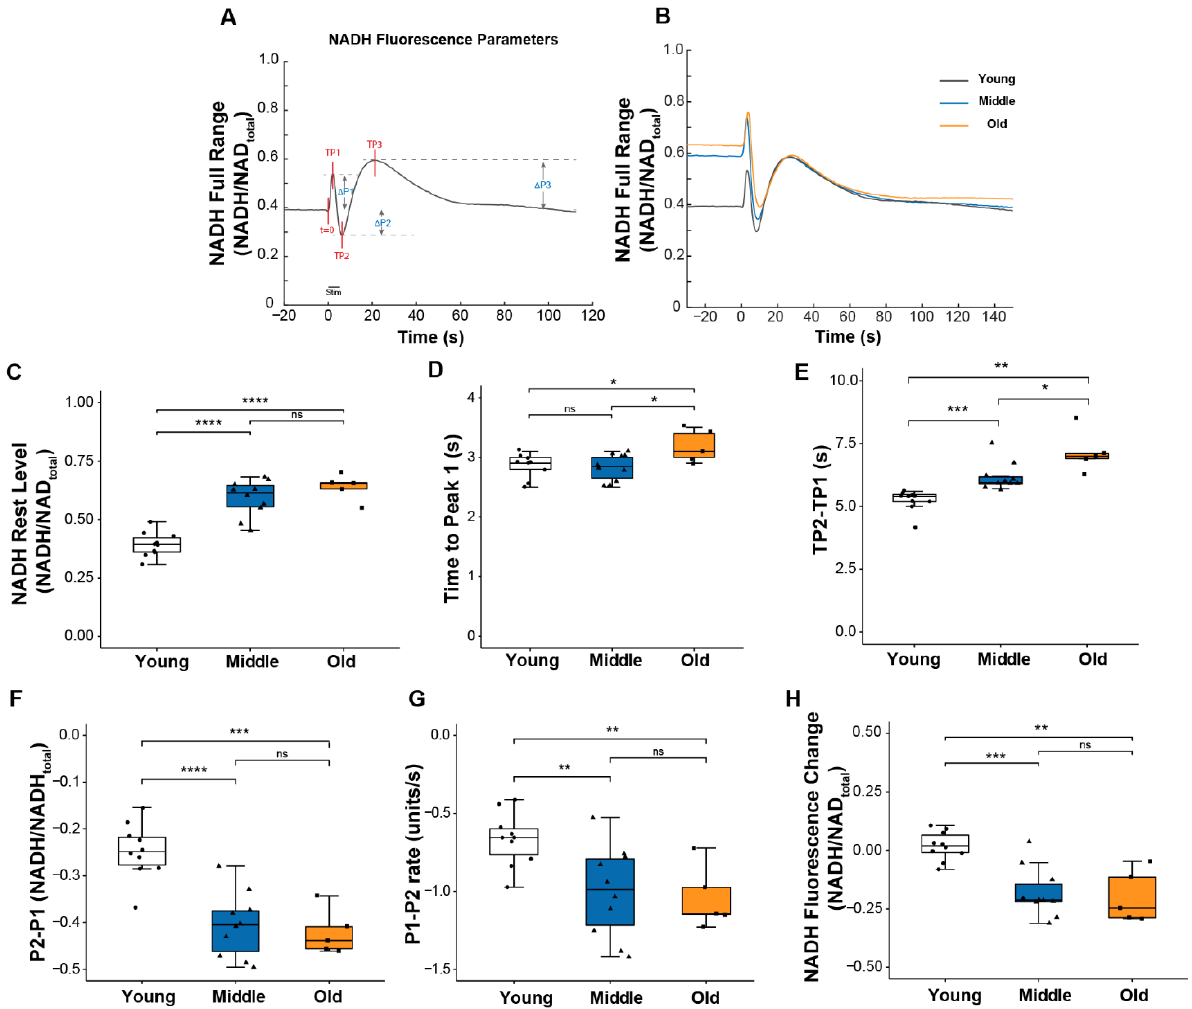
Figure 3. NADH fluorescence response to a 5s tetanic contraction. ( A ) A representative trace of NADH fluorescence dynamics illustrating parameters used to quantify the NADH fluorescence response scaled to maximum and minimum NADH levels. Times to each peak (TP1, TP2, TP3) were measured relative to t = 0; peak amplitudes (ΔP1, ΔP2, ΔP3) were measured relative to pre -contraction resting level. ( B ) Representative NADH fluorescence records for lumbrical muscles of young (black), middle (blue), and old (orange) aged mice. Data are shown for ( C ) basal NADH level prior to contraction, ( D ) time for NADH fluorescence increase to the 1 st peak with contraction, ( E ) time between NADH fluorescence peaks P1 and P2 (TP2 minus TP1), ( F ) amplitude of changes in NADH fluorescence between P1 and P2, ( G ) rate of change in NADH fluorescence between P1 to P2, and ( H ) NADH level recorded 100 s after the end of the contraction relative to rest level for lumbrical muscles of young (n = 10, white), middle (n = 10, blue) and old (n = 5, orange) aged wild type mice. Data in C – H are presented as individual data points with box plots and error bars indicating the minimum, first quartile, median, third quartile, and maximum number of the dataset. Data were analyzed by one-way ANOVA, * p < 0.05, ** p < 0.01, *** p < 0.001, **** p < 0.0001.